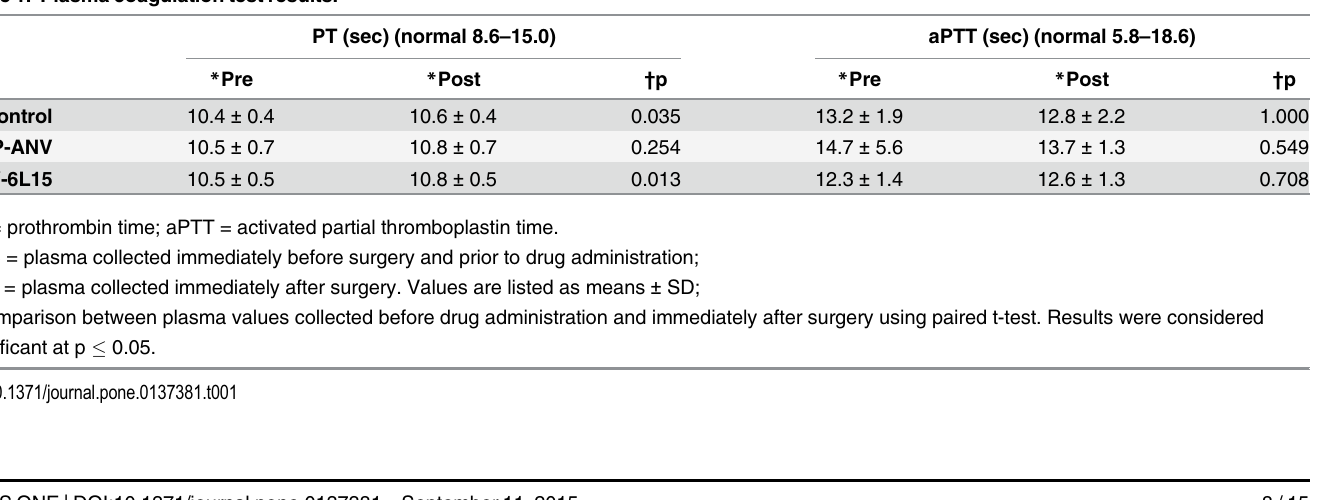
Table 1. Plasma coagulation test